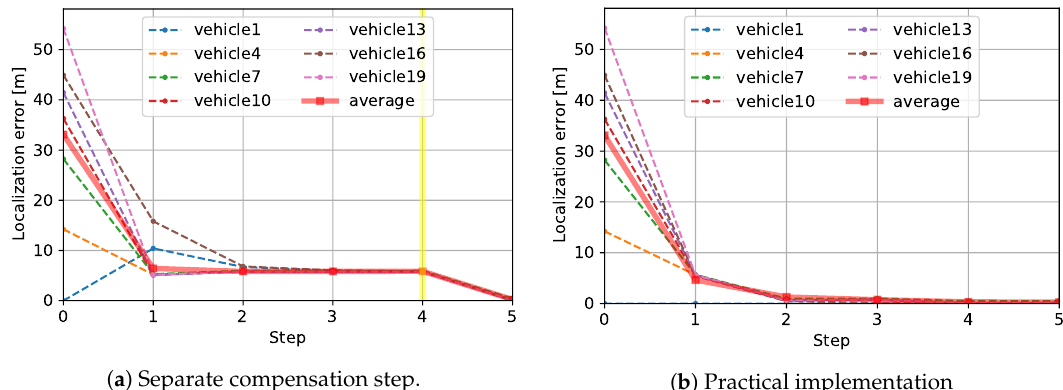
Figure 4. Measurement errors at each